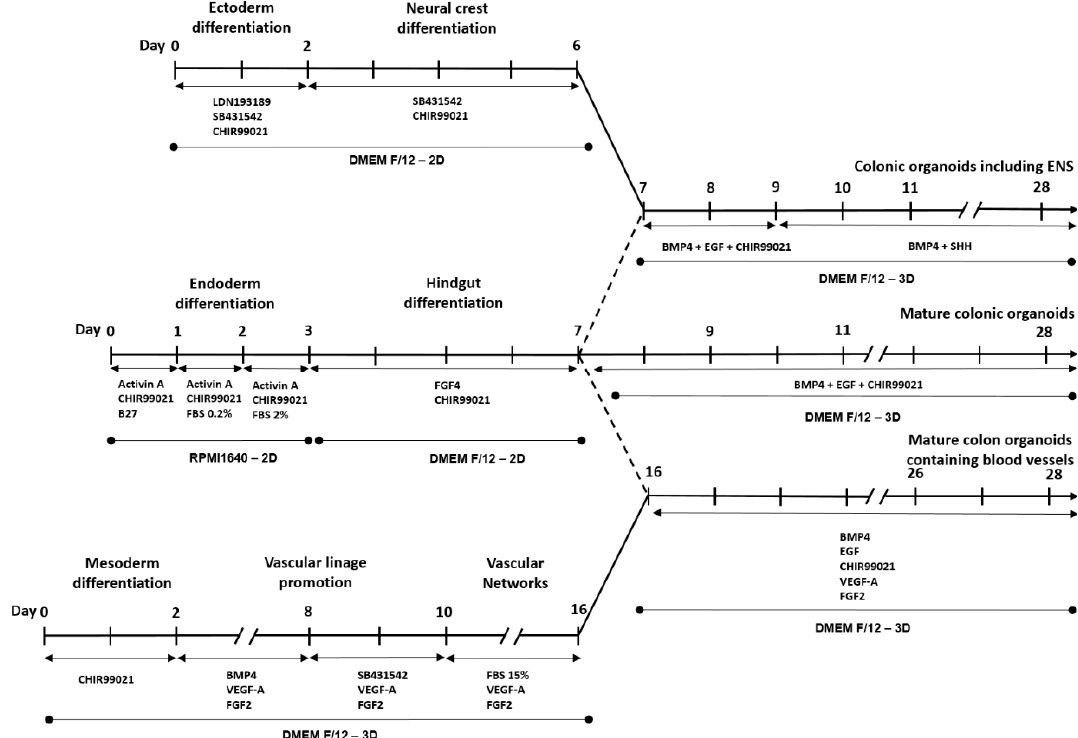
Figure 1. Timeline for the development of enteric nervous system (ENS) and blood vessel ‐ containing human colonic organoids (HCOs) from human embryonic stem cells (hESCs). The dashed line indicates the 3D co ‐ culture.